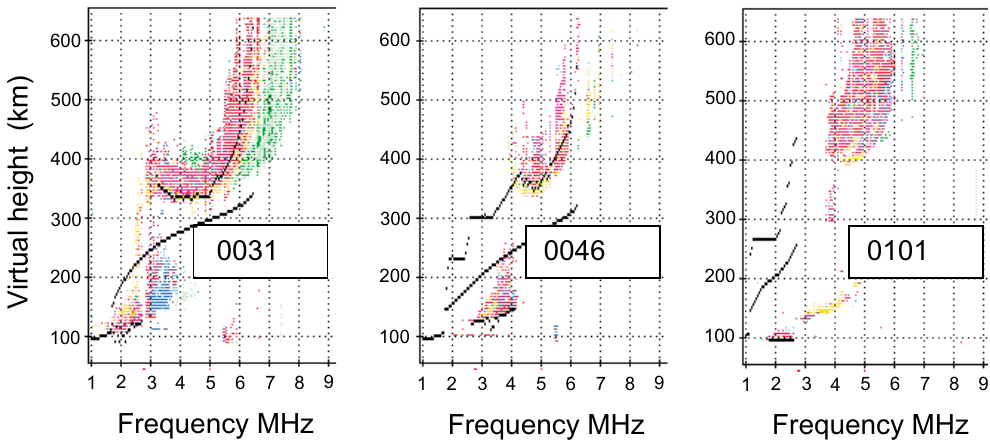
Fig. 1. Digisonde data from Tromsø, Norway for 5 July 2002. Notice the development of the layer below 100km.